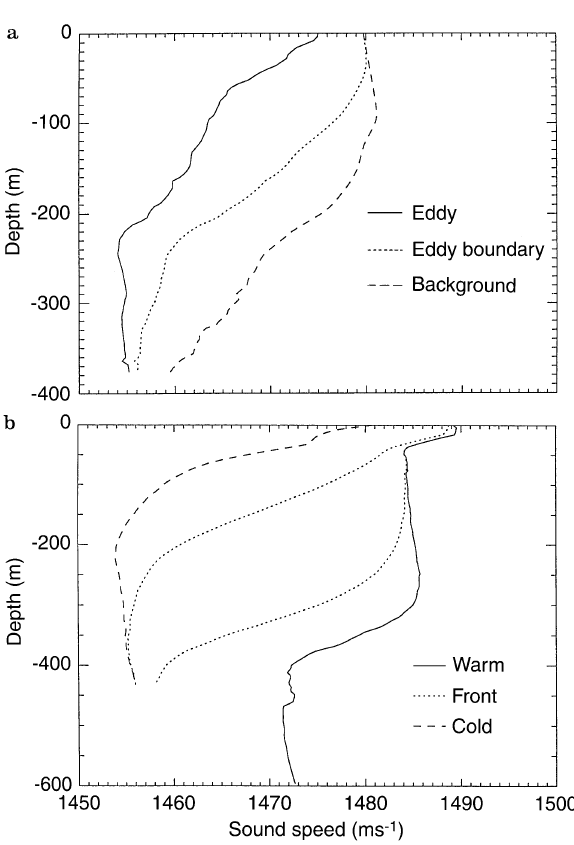
Fig. 8a, b. Sound-speed profiles (SSPs) taken from the feature mod- els: a SSPs at the eddy centre, in the background and on the